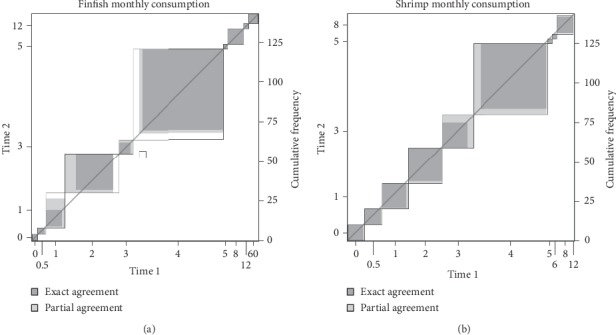
Illustration of the agreement in response to the yearly frequency of the consumption of finfish (a) and shrimp (b) between the two administrations of the questionnaire. Both items displayed an almost perfect agreement based on kappa coefficients of 0.99 and 0.86 (a and b, respectively) in the reliability assessment.